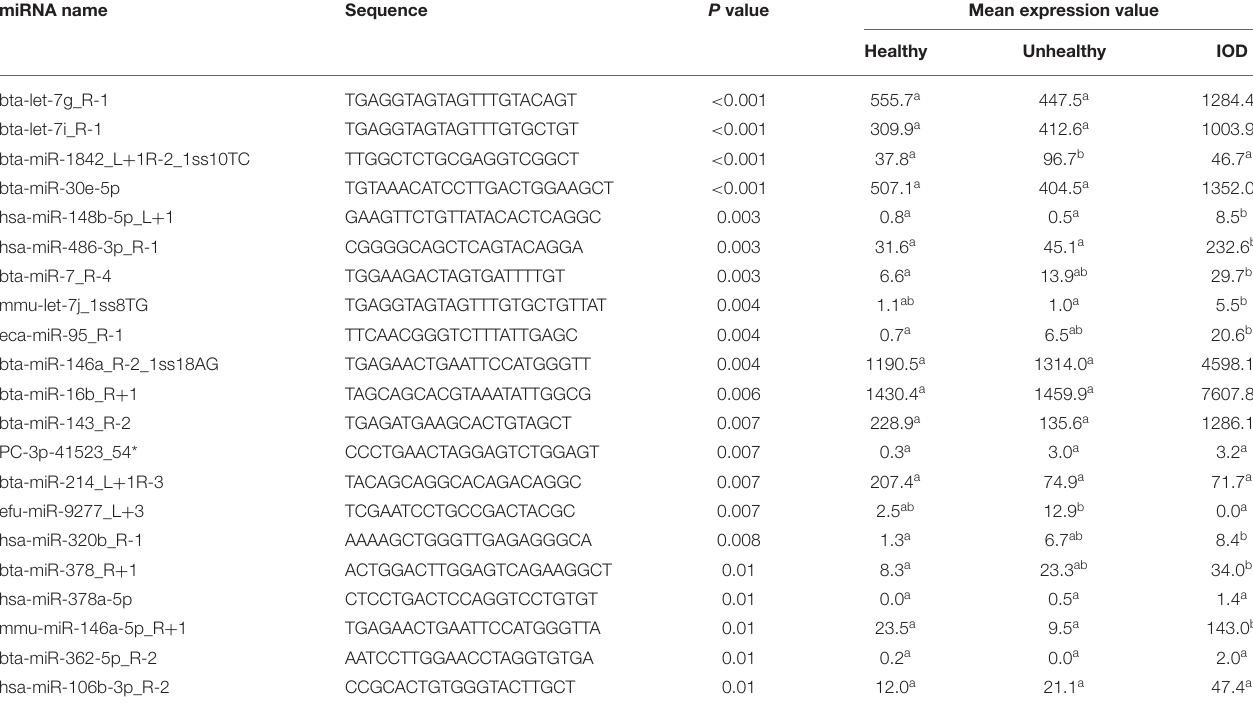
TABLE 1 | Differentially expressed serum miRNA normalized sequence count means of healthy ( n = 9), unhealthy ( n = 5), and IOD ( n = 4) afflicted black ( Diceros bicornis ) and Sumatran ( Dicerorhinus sumatrensis ) rhinos ( P ≤ 0.01). miRNA